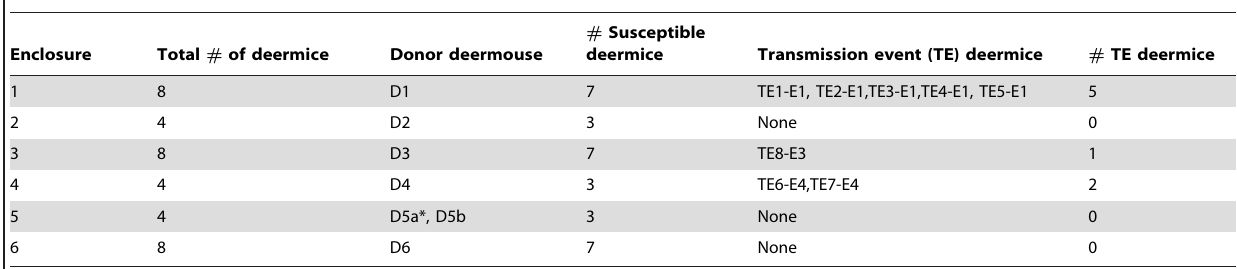
Table 2. Experimental details for experiment